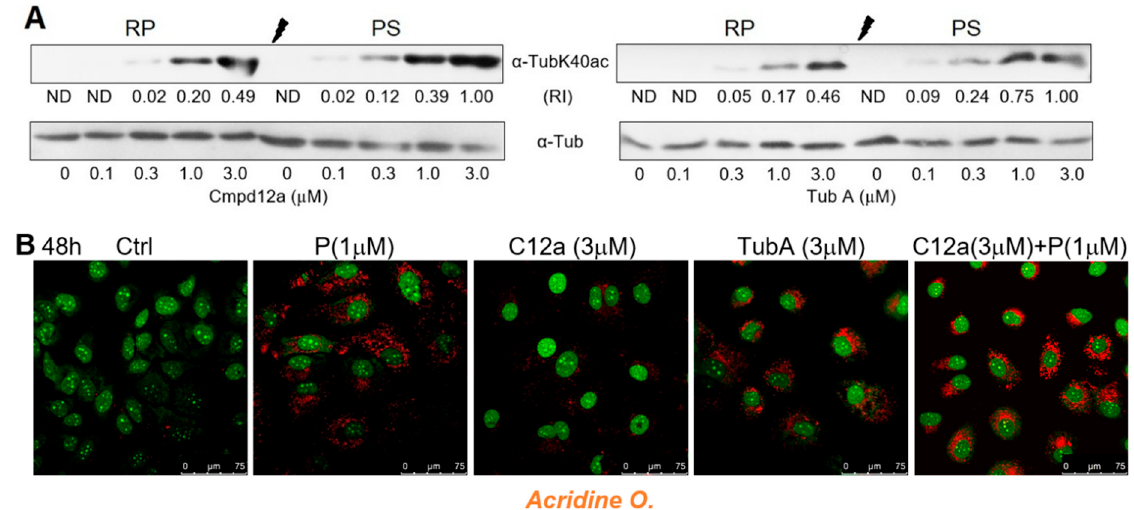
Figure 5. Inhibition of HDAC6 and HDAC6/10 by Cmpd12a and tubastatin A in Huh7-luc/neo cells. ( A ) Inhibition of HDAC6 deacetylation activity by Cmpd12a and tubastatin A in regularly proliferating (RP) and pre-senescent (PS) Huh7-luc/neo cells treated with indicated concentrations of inhibitors for 24 h, assessed by WB analysis of relative intensity (RI) of the α -tubulinK40ac band versus the α -tubulin band (ND—not defined). ( B ) Confocal microscope images of Acridine Orange- stained cells treated with indicated concentrations of Cmpd12a (C12a), tubastatin A (Tub A), and palbociclib (P) for 48 h.